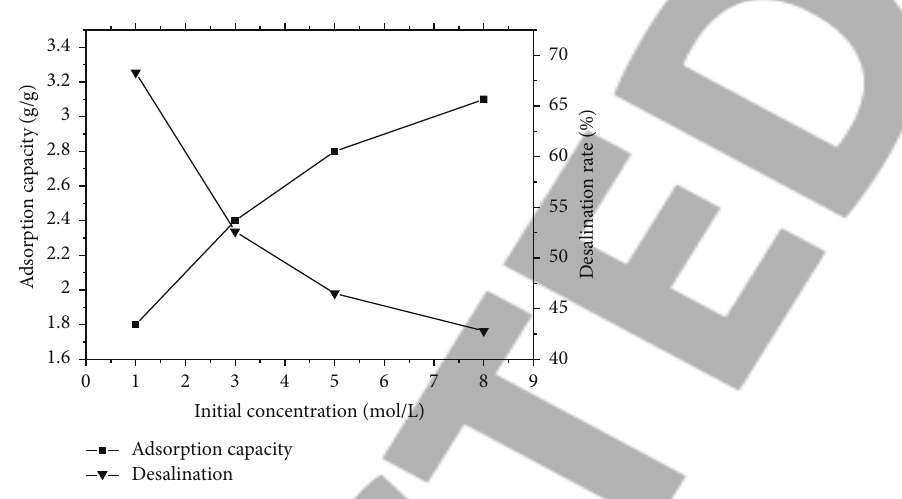
Figure 7: Adsorption capacity and desalination at different initial concentrations.